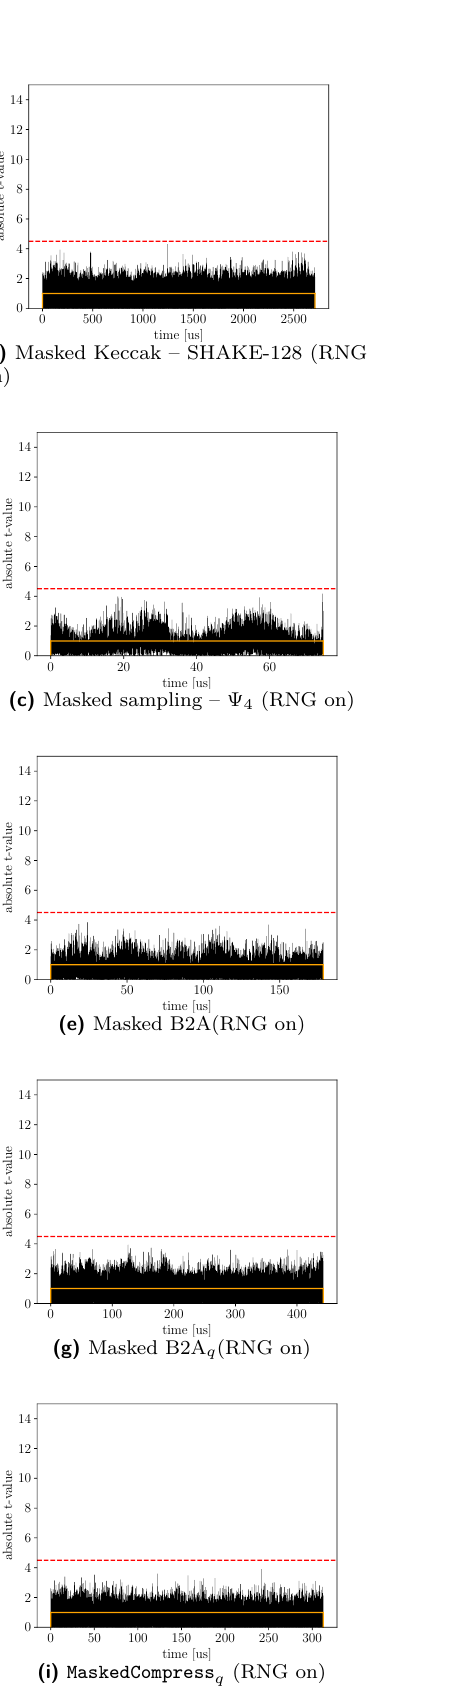
Figure 13: TVLA results for all non-linear operations with their accelerators given a total amount of 100 , 000 traces. The confidence interval ( t = 4 . 5) is shown as dotted red line, while the trigger interval is given in